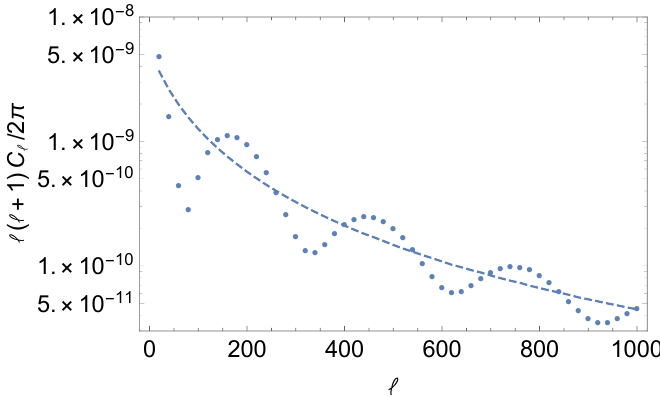
Figure 2. The behavior of the angular-power spectrum of CMB temperature fluctuations C BD line) and C cl (cid:96) (dashed line). C BD (cid:96) shows the oscillatory behavior and C cl (cid:96) does not have such a